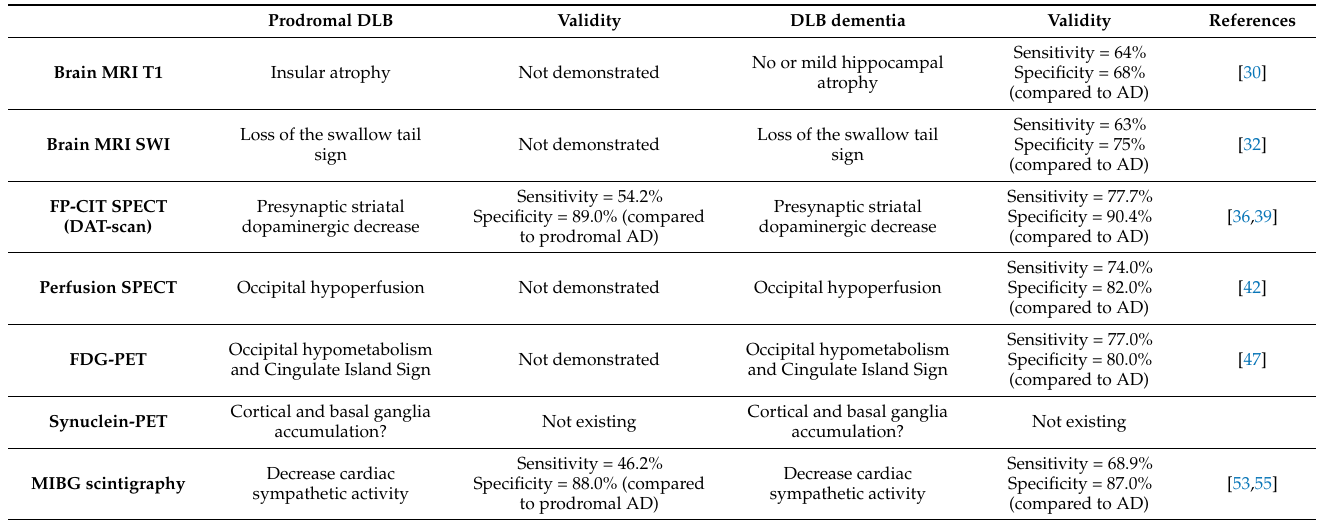
Table 2 summarises the neuroimaging diagnosis of DLB patients. Table 2. Neuroimaging and diagnosis of dementia with Lewy